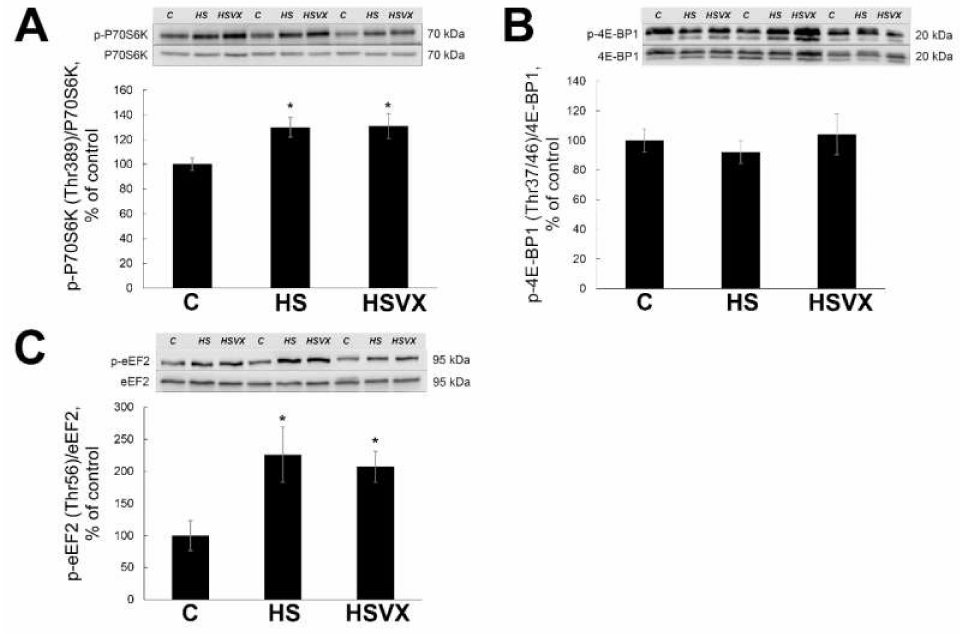
Figure 8. Evaluation of phospho-p70S6K ( A ), phospho-4EBP1 ( B ), and phospho-eEF2 ( C ) content in soleus muscles of C, HS, and HSVX rats by Western blotting. Values are normalized to the levels of total protein and total p70S6K, 4E-BP1, and eEF2 content in each sample. n = 8. * indicates a significant di ff erence from the control, p <